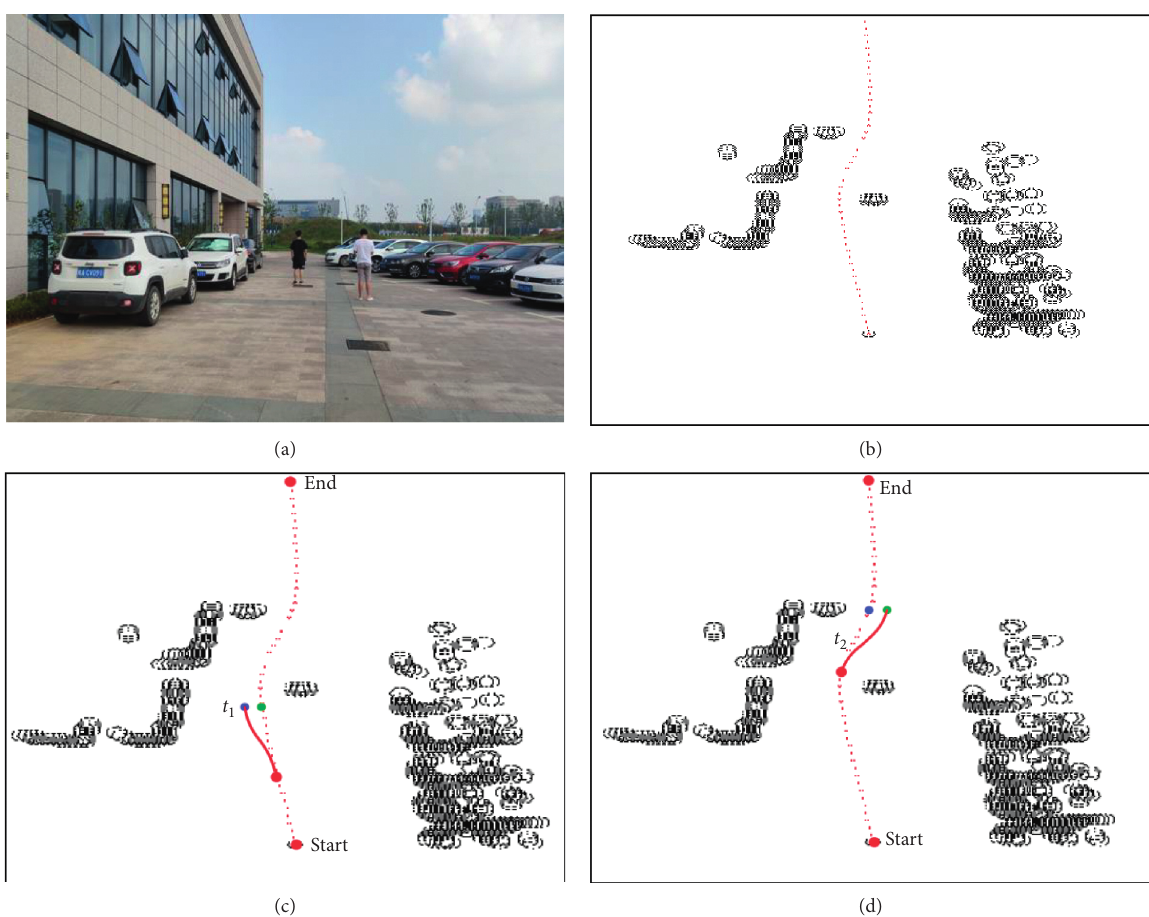
Figure 23: The results of two-layered path planning method in scenario 2. (a) The experiment scenario. (b) The improved Bi-RRTplanning result in high-level model. (c) The planning result of low-level model at time t 1 . (d) The planning result of low-level model at time t 2